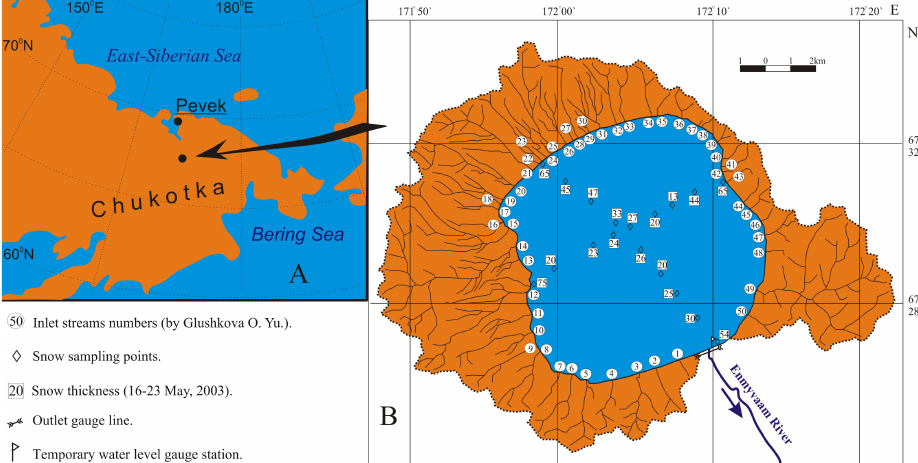
Fig. 1. Location (a) and scheme (b) of the Lake El’gygytgyn drainage